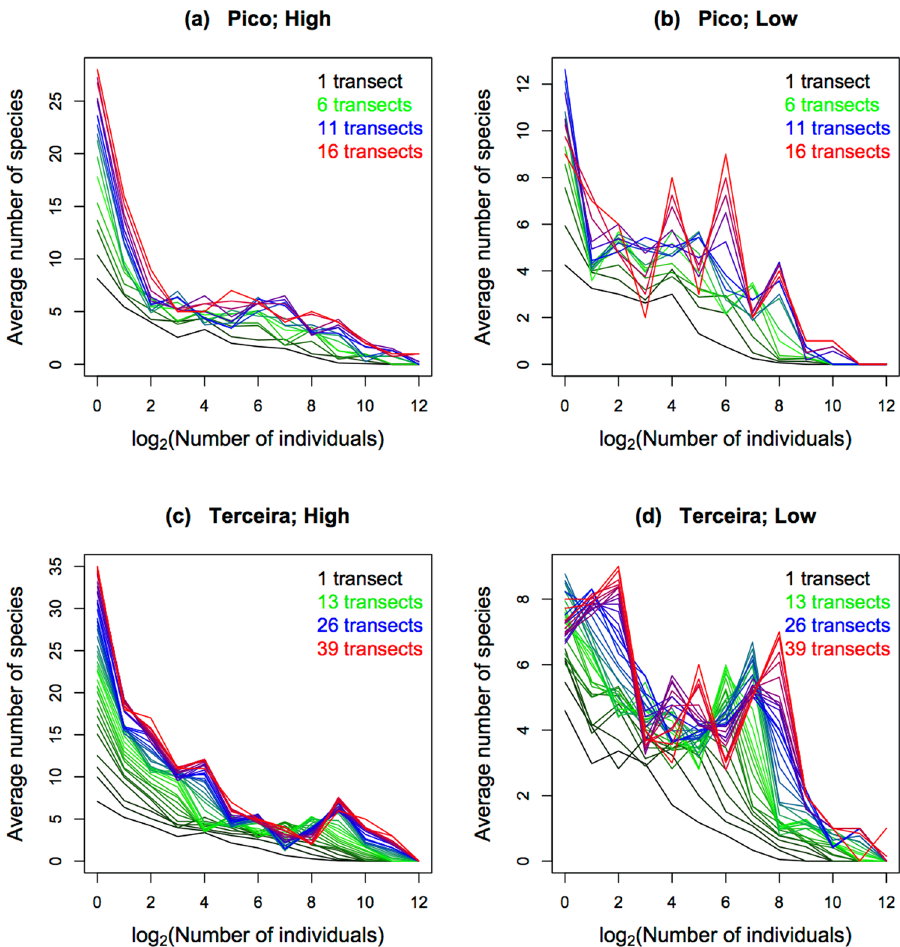
Figure 3. SADs of Pico and Terceira islands for arthropod species groups with high and low dispersal abilities. Each curve corresponds to the average of all possible SAD curves obtained by using the concentric procedure as explained in the Methods. The x-axis corresponds to classes of the logarithm of base 2 of the number of individuals as follows: 1 individual, 2 to 3 individuals, 4 to 7 individuals, et seq . In order to better illustrate the evolution of the shapes of the distributions, the curves have a gradient of colours going from black (the smallest number of transects), through green and blue, to red (the largest number of transects). In all cases we can observe the development of humps when the number of transects increases. However, while for species with high dispersal ability the number of singletons keeps increasing with the number of transects, for species with low dispersal the number of singletons decreases for the largest number of transects; in fact, for Terceira, when a large number of transects is added, the absolute maximum no longer occurs for the singleton abundance class, but for some intermediate